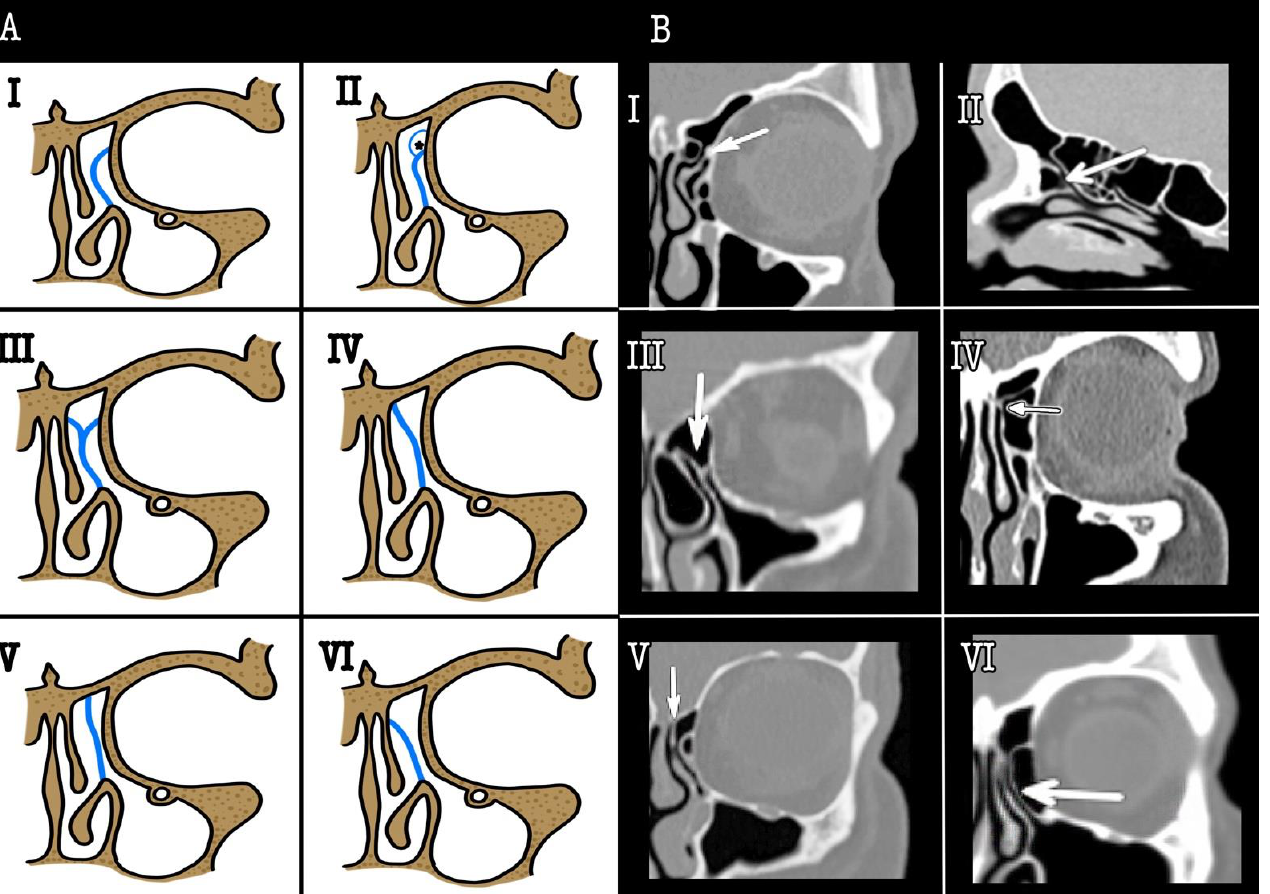
Figure 1. SAUP types (modified from Landsberg and Friedman (2001). Panel ( A ): graphical representation. Abbreviations: uncinate process in blue; asterisk (agger nasi cell). Panel ( B ): CT scans. A white arrow shows the uncinate process superior attachment.